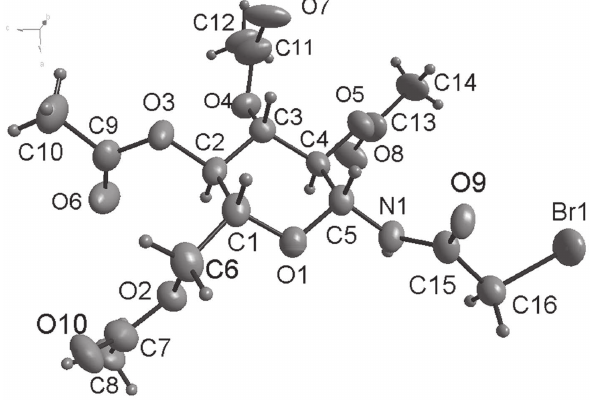
Table 1: Data collection and